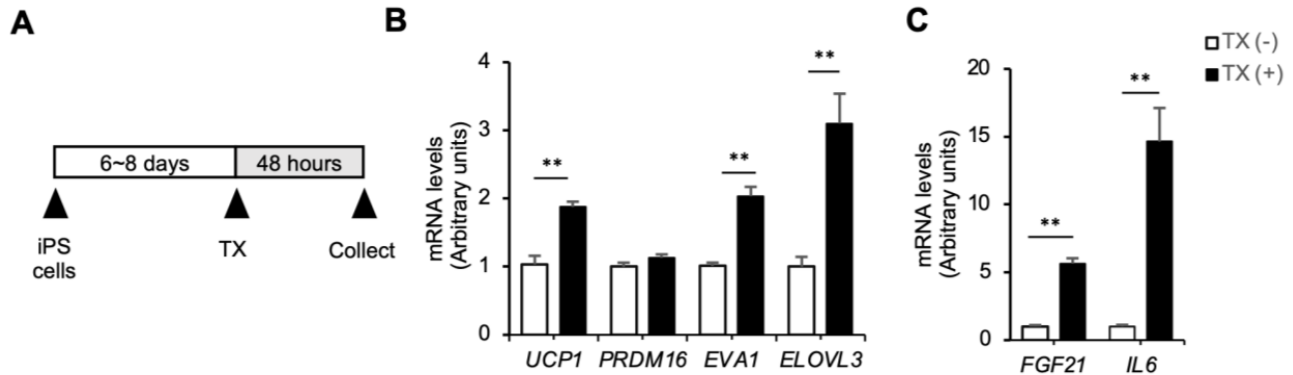
Figure 4. Direct action of Taxifolin on brown adipocytes: ( A ) experimental protocol: human iPS cell-derived brown adipocytes (hiPSCdBAs) were differentiated and then treated with Taxifolin at 100 µ M for 48 h; ( B ) expression levels of genes related to brown adipocyte markers ( UCP1 , PRDM16 , EVA1 , and ELOVL3 ); ( C ) expression levels of FGF21 and IL6 mRNAs in the hiPSCdBAs. Values are presented as the means ± SEM; n = 3; significant differences: ** p < 0.05 vs. hiPSCdBAs without Taxifolin treatment.